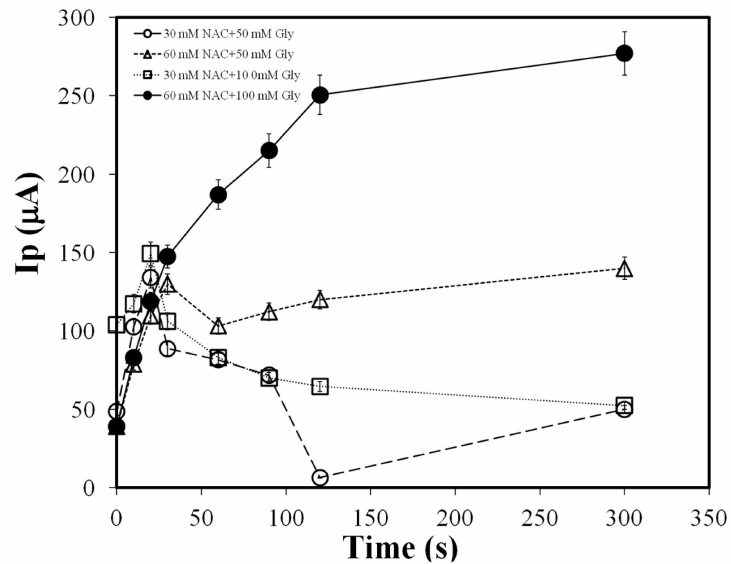
Figure 5. The response stability of the reagent compositions (glycine and NAC). Curves represent temporal dependence of the peak current of cyclic voltammograms for various compositions, including ( ) 30 mM NAC/50 mM glycine, ( (cid:52) ) 60 mM NAC/50 mM glycine, ( (cid:3) ) 30 mM NAC/100 mM glycine, • (cid:35) and ( ) 60 mM NAC/100 mM glycine in the presence of 0.6% OPA with bare SPCE at +0.7 V. (n =